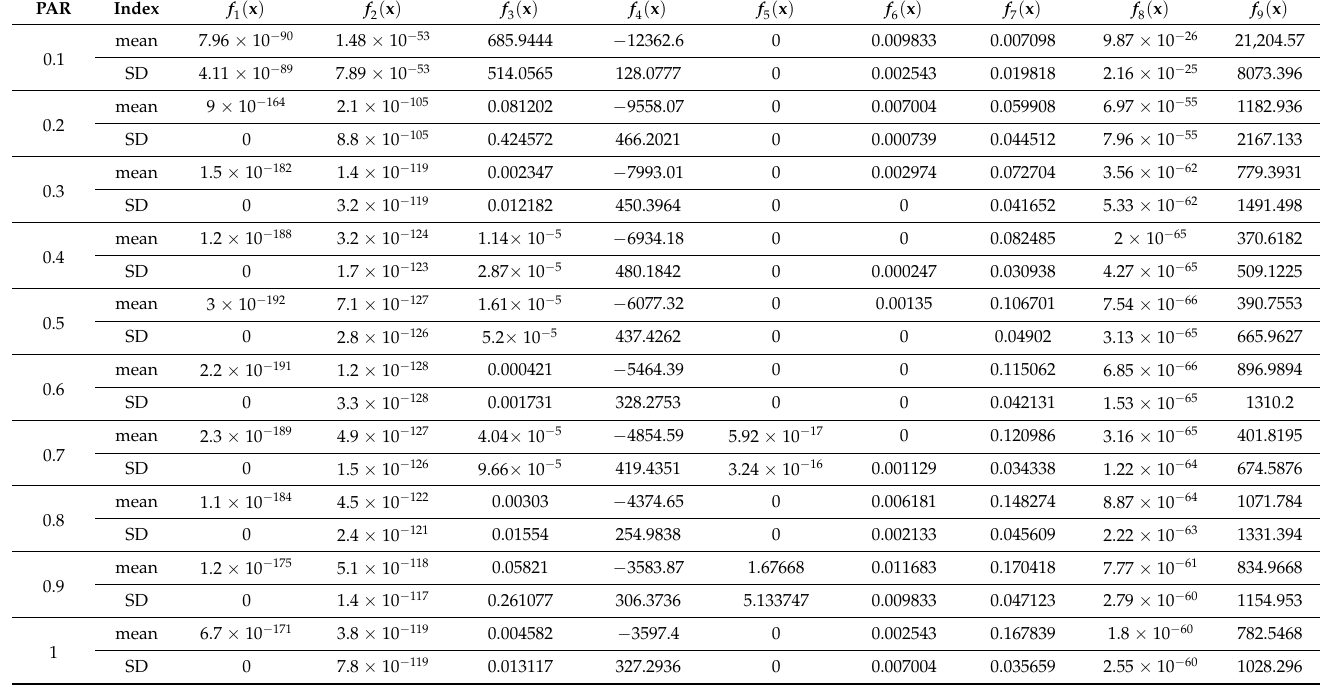
Table 3. Effects of PAR for nine functions.